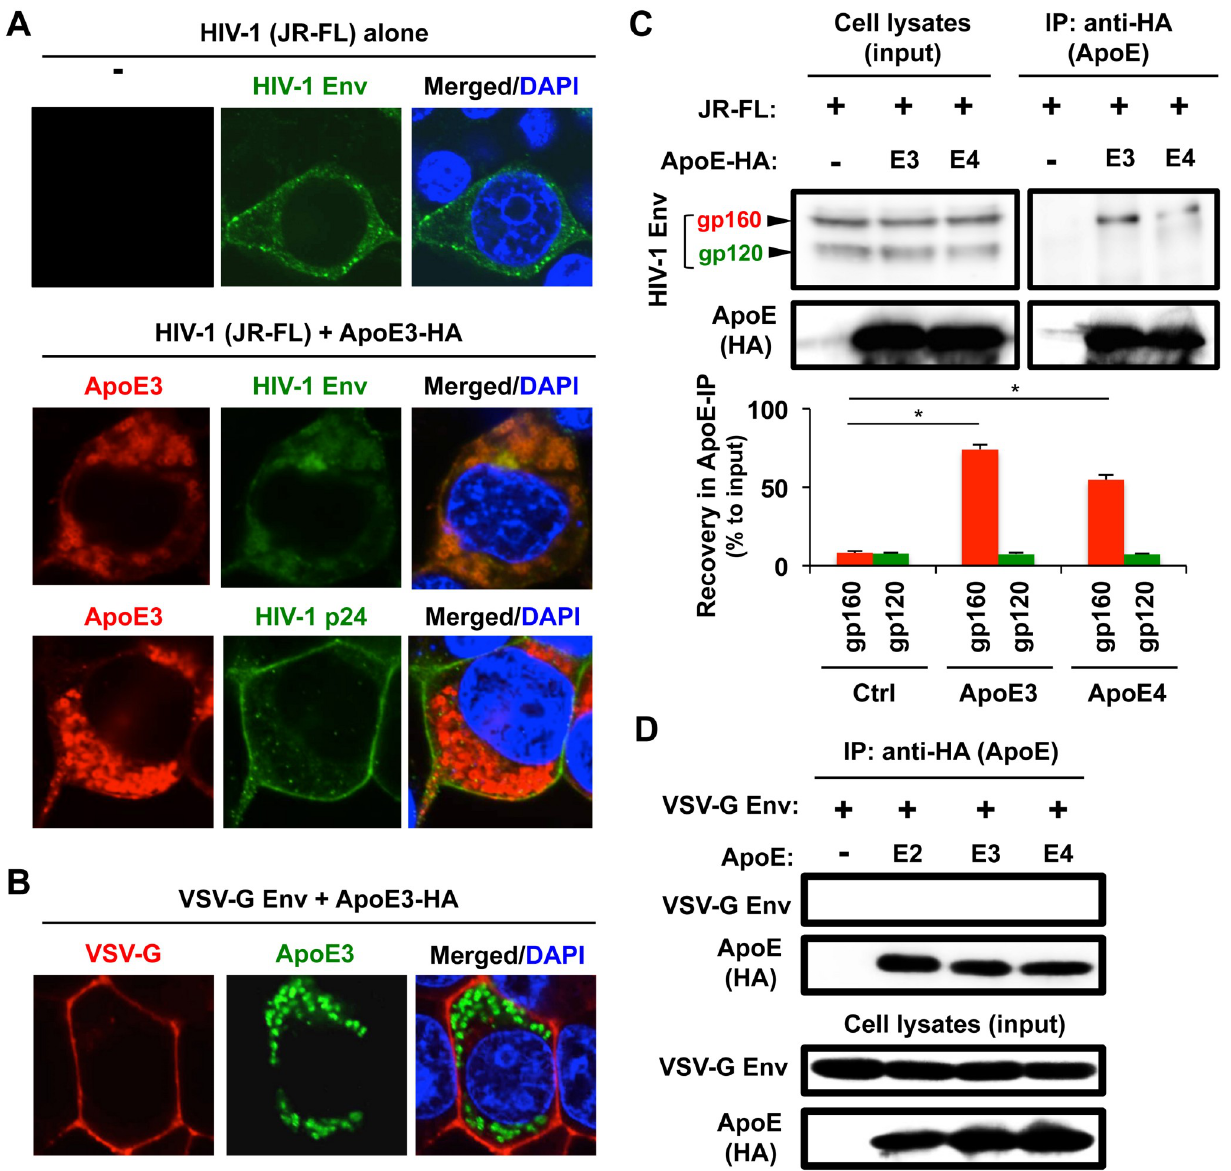
Fig 6. Effect of exogenous expression of ApoE on the localization of Env, and the association between ApoE and gp160 Env in 293T cells. (A) The 293T cells were transfected with 100 ng of the HIV-1 molecular clone JR-FL (top panels), or co-transfected with 100 ng of the HA-tagged ApoE3 expression vector (middle and bottom panels) in a 2-well chamber slide. Twenty-four hours post-transfection, the cells were stained with anti-HIV-1 Env, anti-HIV-1 p24, or anti-HA antibody, and the signals were visualized with AlexaFluor488 goat anti-Human IgG or AlexaFluor594 donkey anti-mouse IgG. Nuclei were stained with DAPI (blue). Original magnification x600. (B) The 293T cells were co-transfected with 100 ng of VSV-G Env expression vector and 100 ng of HA-tagged ApoE3 expression vector, in a 2-well chamber slide. Twenty-four hours post-transfection, the cells were co-stained with anti-VSV-G antibody (red), anti-HA antibody (green) and DAPI (blue). Original magnification x600. (C) The 293T cells were transfected with 4 μ g of the HIV-1 molecular clone JR-FL or 4 μ g of the indicated HA-tagged ApoE expression vector (either ApoE3 or ApoE4). The cell lysates were mixed and incubated with the anti-HA antibody (to precipitate the ApoE complex), and the ApoE immunoprecipitates (IP) were analyzed for the presence of Env by western blot (upper right). The level of Env in the total cell lysates is also shown (upper left, “input”). The arrowheads indicate the precursor (gp160) and mature form (gp120) of Env. In the bar graph, the gp160 or gp120 levels (quantified by the densitometric analysis) in the ApoE immunoprecipitates are represented as percentages relative to those in total cell lysates (”Recovery in ApoE-IP”), and results obtained from three independent experiments are summarized. � p < 0.0001. (D) The 293T cells were transfected with 2 μ g of VSV-G Env expression vector, or co-transfected with 2 μ g of the indicated HA- tagged ApoE expression vector. Then, the cell lysates were immunoprecipitated as in (C), and the ApoE immunoprecipitates (IP) were analyzed for the presence of VSV-G Env by western blot (upper). The level of VSV-G Env in the total cell lysates is also shown (lower, “input”).